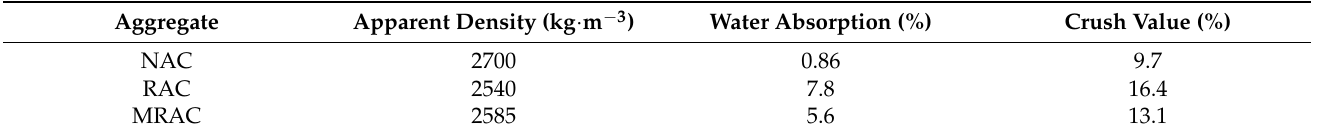
Table 3. Properties of aggregate.